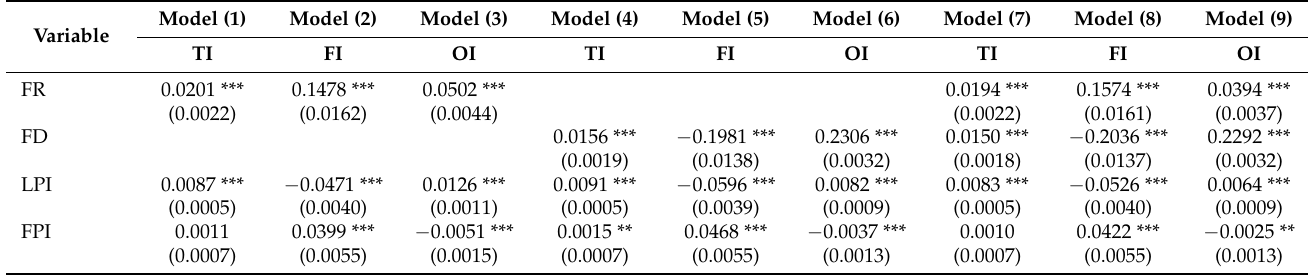
Table 2. Benchmark regression